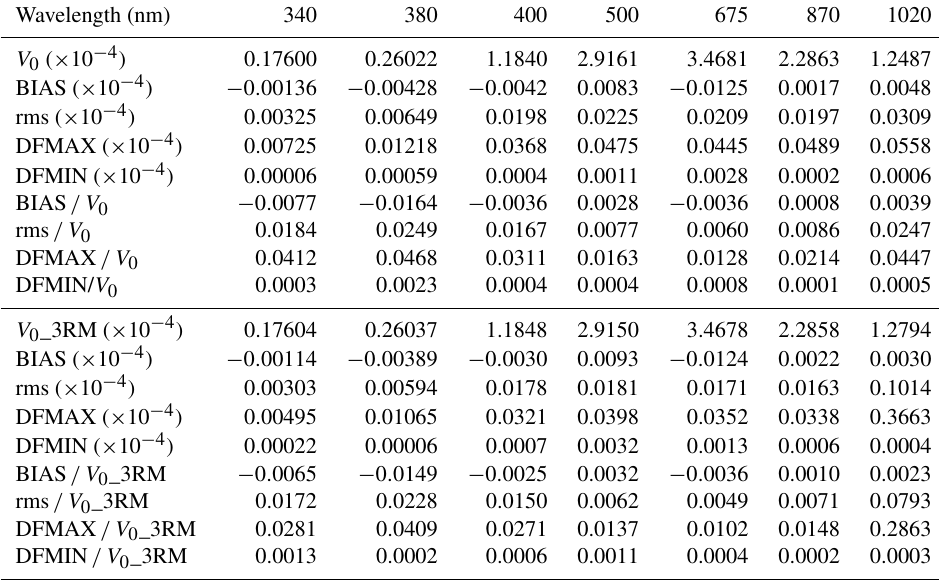
Table 4. Statistics of the difference between IML method and normal Langley